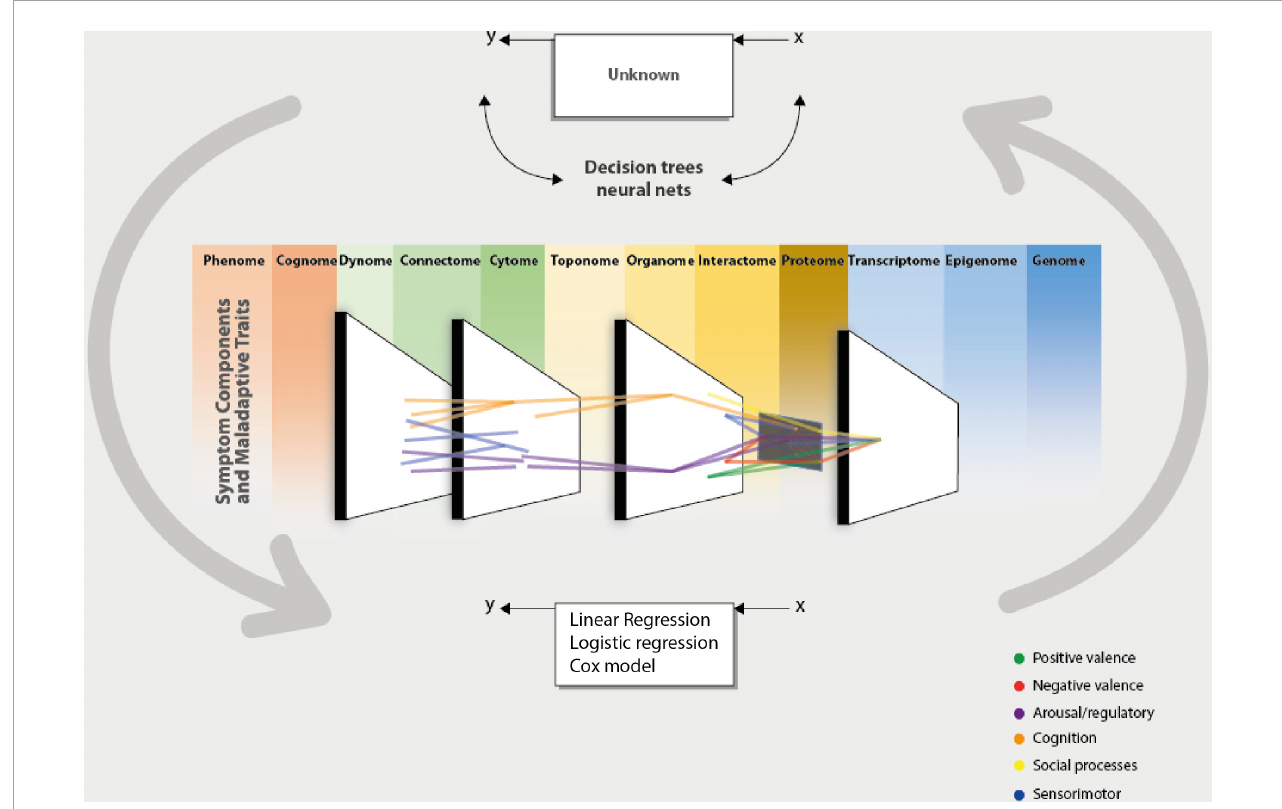
FIGURE1 Computational psychiatry aids the clinician and the researcher in integrating data from different sources of information, which could be taken from the omics perspective. This integration is made possible by complementing the data modeling culture using the algorithmic modeling culture proposed by Breiman (43). This permits the validation of models or data that can be measured by predictive accuracy. By taking these inputs and processing them through a computational system (algorithm), one could present data-driven or theory-driven responses to clinical and research questions. This enables us to bring forward an integrative and cohesive framework associated with others. The network theory can integrate the different units of analysis (scale level) of a phenomenon or give a cohesive picture of the interaction between different domains. And in turn, this could give us a more precise phenotype to arrive at a dimensional conception (HiTOP). These computational approaches to understanding psychiatry represent the brain’s functioning [phantastic organ (20)]. In other words, using computational approaches to comprehend psychiatry mimics the normal functioning of the statistical machine we call the